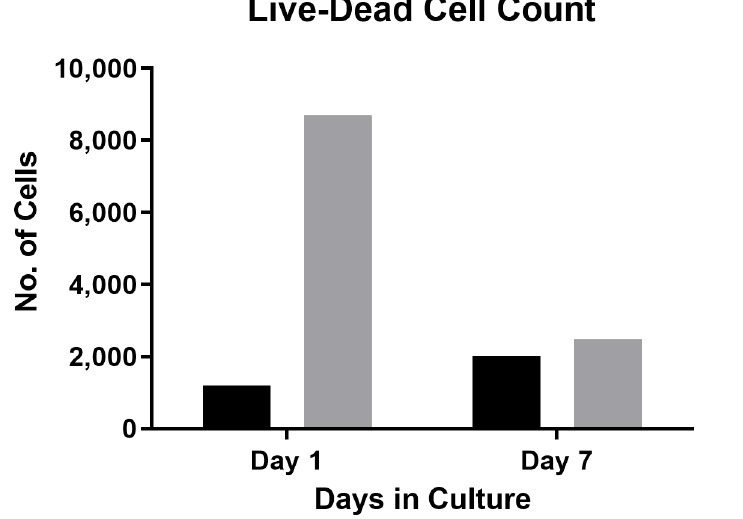
Figure 7. Live-dead cell count analysis. Using ImageJ software (live-dead plugin), number of liver cells were quantified on day 1 and day 7. There is an increase in the number of live cells 7 days post culture; almost double the number of live cells observed a week after culture, and this indicates cell viability and replication. Table 1. Analysis of live and dead cells at day 1 and day 7 post culture.